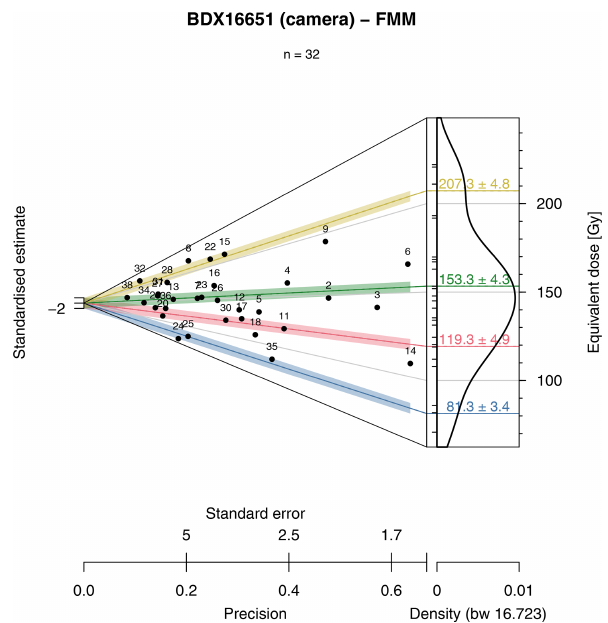
Figure 7. Abanico plot for sample BDX16651 with coloured poly- gons indicating dose components as identified by the finite mixture model. Further details see main text.